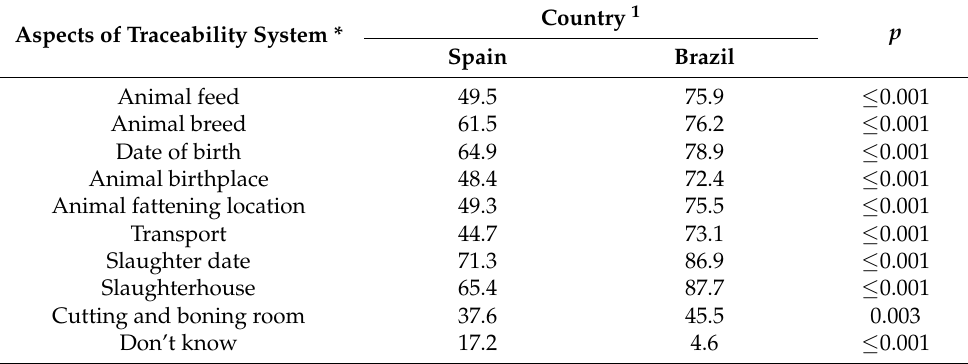
Table 2. Aspects assumed by Spanish and Brazilian consumers are part of the current traceability system for